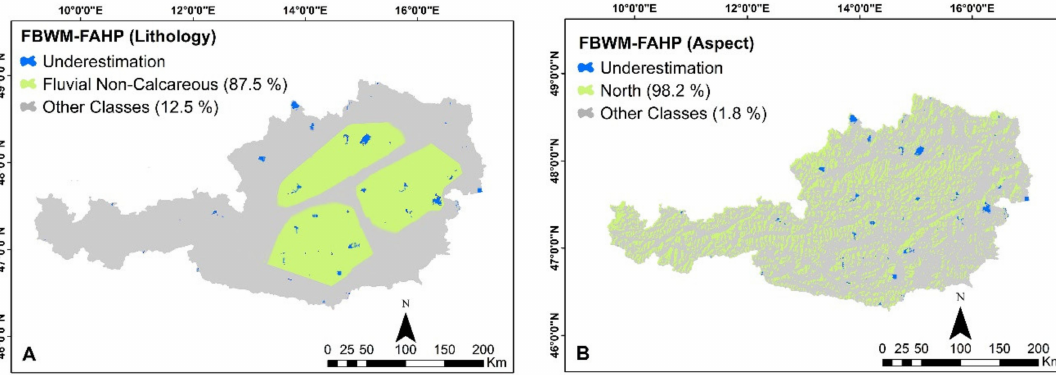
Figure 9. Spatial location of underestimations, in relationship with the imbalanced